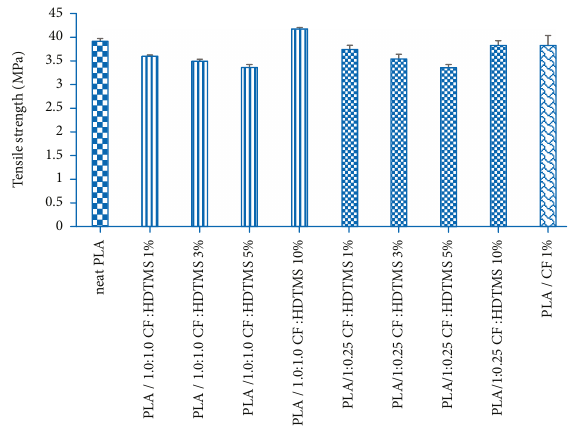
Figure 4: Tensile strength values of neat PLA and PLA/ hydrophobic CF/SiO composites. 2